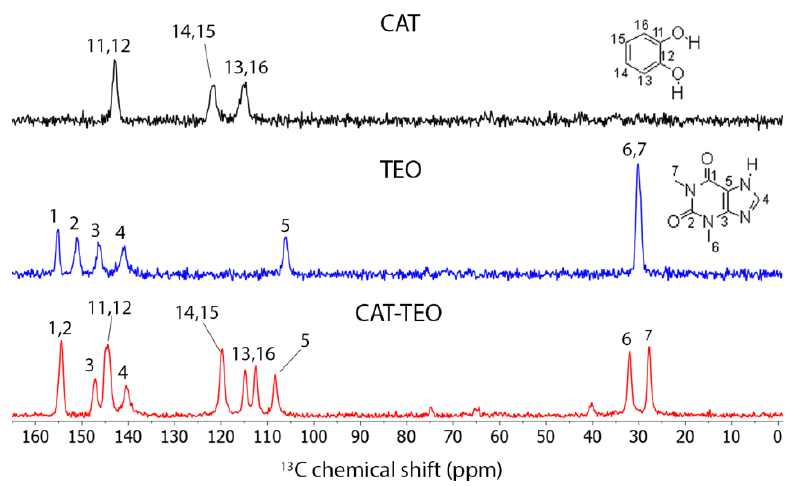
Figure 4. Solid-state 13 C CP/MAS NMR spectra ( δ = ppm) of the CAT-TEO cocrystal and the starting products catechol (CAT) and theophylline (TEO). Table 2. CP/MAS solid state 13 C NMR chemical shifts of CAT, TEO and the CAT-TEO cocrystal.